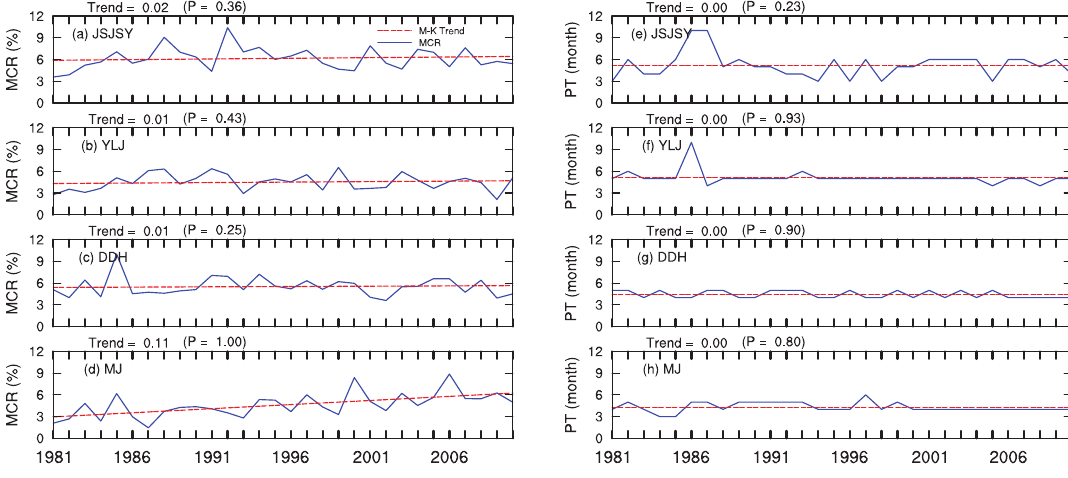
Figure 6. Modeled interannual variation in ( a – d , blue solid line) melt runoff contribution to total runoff (MCR, %) and ( e – h , blue solid line) the corresponding peak time of MCR (PT, month) in four sub-regions (JSJSY, YLJ, DDH, and MJ) with the most notable MCR values from 1981 to 2010. The Mann-Kendall (M-K) trends for MCR ( a – d , red dashed line) and PT ( e – h , red dashed line) are also shown, and the Theil-Sen trend estimator (Trend) and corresponding M-K trend significance ( P ) are listed above each